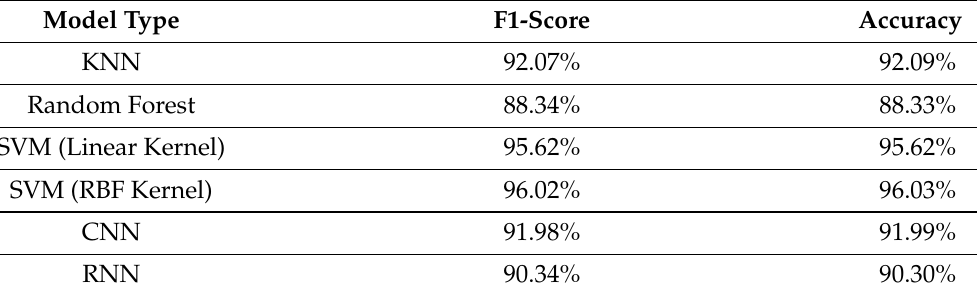
Table 12. Performances of the best performing models for each evaluated model type on the UCI HAR dataset.